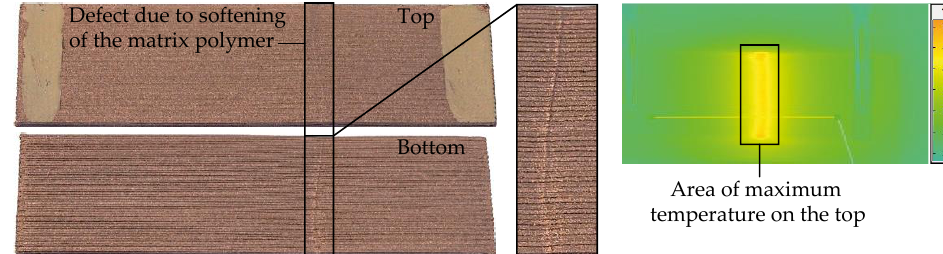
Figure 3. Damage of the specimen caused by softening of the PCL matrix due to resistive heating at a voltage of 12 V and a maximum temperature of 43.5 °C.